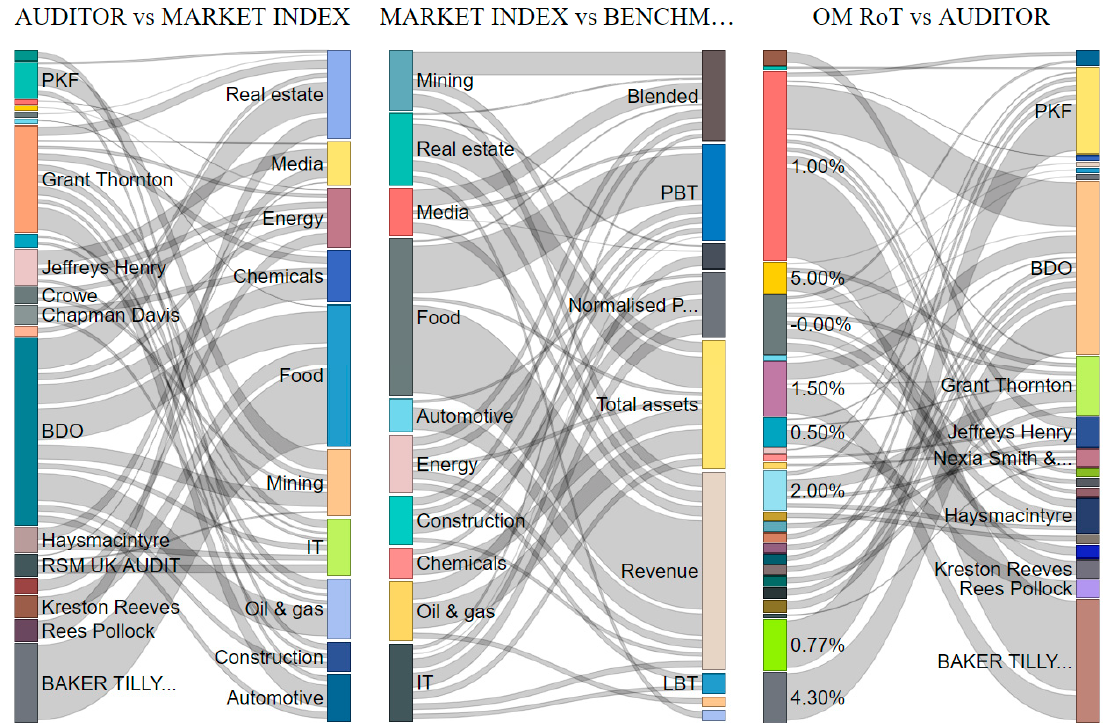
Figure 11. Relationships between auditors, benchmarks, OM RoT and WIGs—for non-Big 4 auditing firms. Source: own elaboration based on analyzed data.